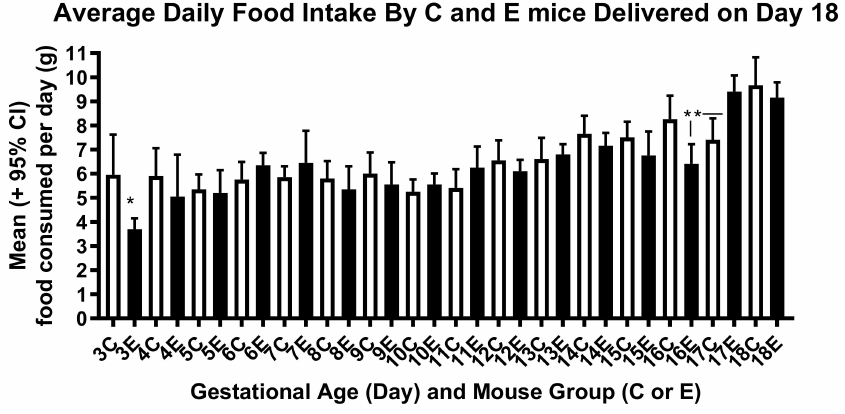
Figure 7. Daily food intake of the control (C) and experimental (E) mice that delivered on day 18 of pregnancy. The di ff erence between the two groups is statistically significant on day 3 (t-test, p < 0.05). In addition, a significant increase in food intake occurred in the experimental mice on day 17 (ANOVA with multiple comparison tests for all E data including 16E vs. 17E, p < 0.0001), but such was not the case in the control mice until day 18. Single and double asterisks (*, **) indicate mean values that are significantly di ff erent from each other (control mice, n = 10 dams; experimental mice, n = 10 dams). The number of mice is higher in Figure 4 for experimental mice because food intake was measured reliably in only 10 mice, and the number is lower for control mice in Figure 4 because one mouse delivered on day 18, before dissection could